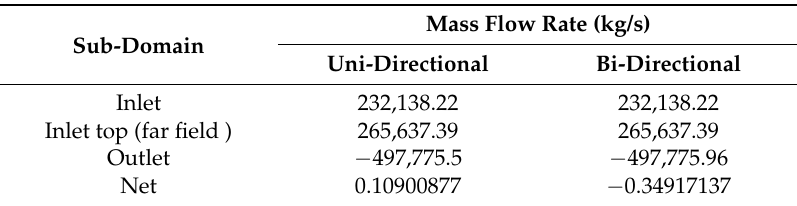
Table 4. Mass imbalance of the two